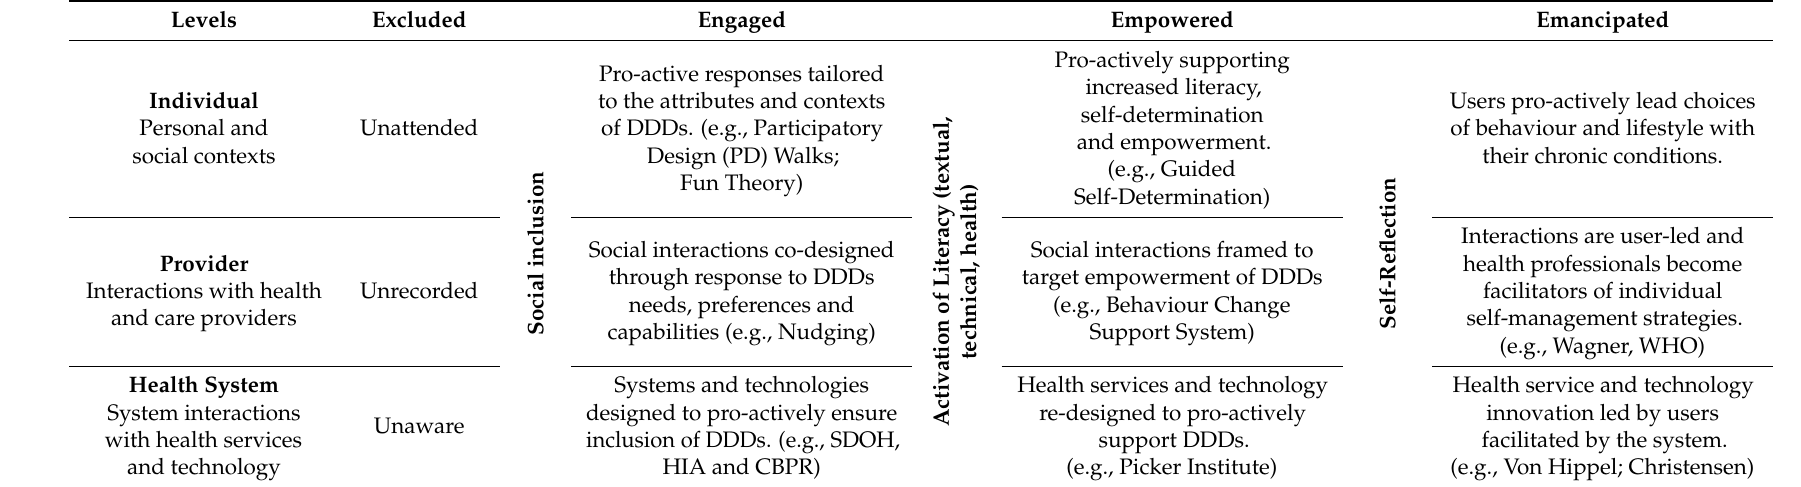
Table 1. The 4E matrix, a framework for the co-production of digital services for